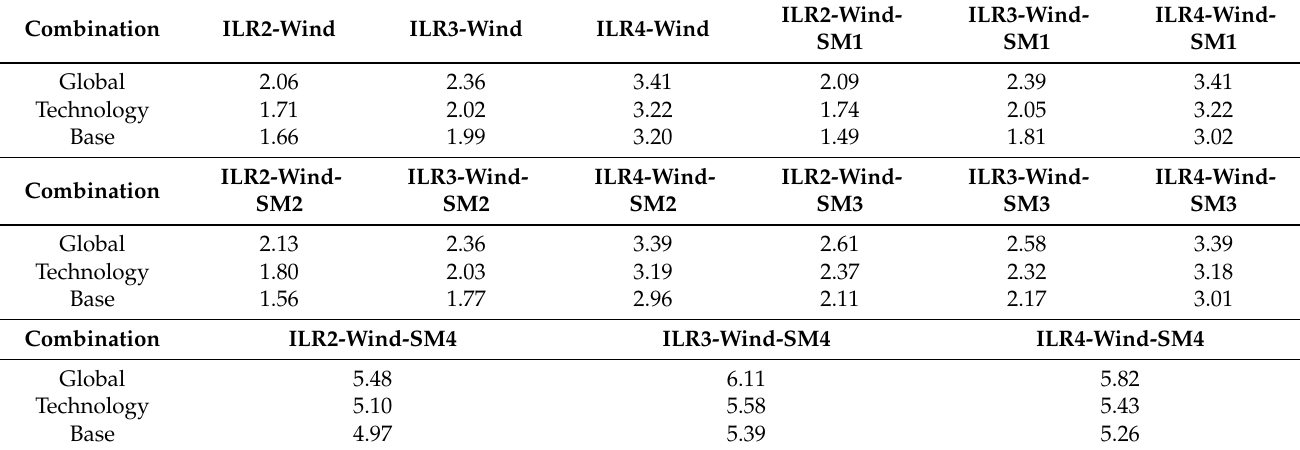
Table 10. Mean–standard deviation ratios (12) of the global, technology and base fronts without the maximum-cost constraint for different combinations (Table 5). SM1: CSP without storage; ILR > 1 or SM > 1: with increasing levels of storage from PV or